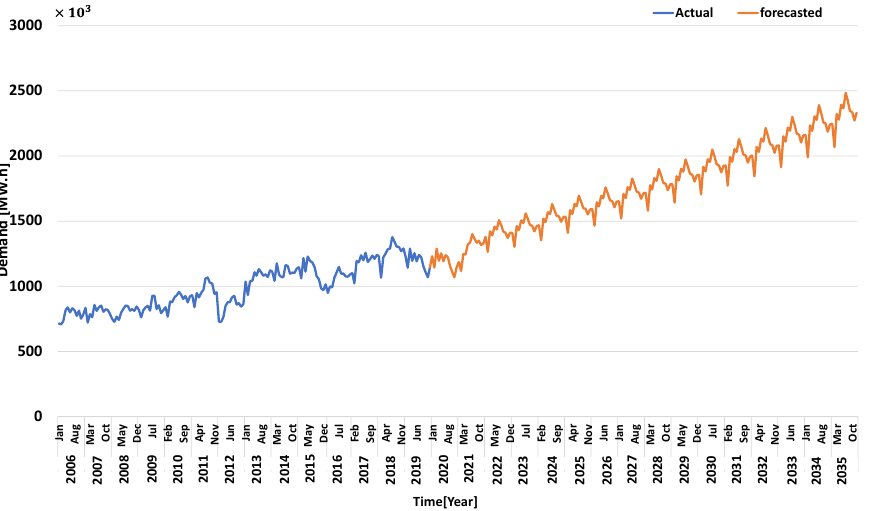
Figure 10. ACF and PACF of the residual. The developed SARIMA model was used to predict the future electricity demand in Zambia, which is shown in Figure 11.